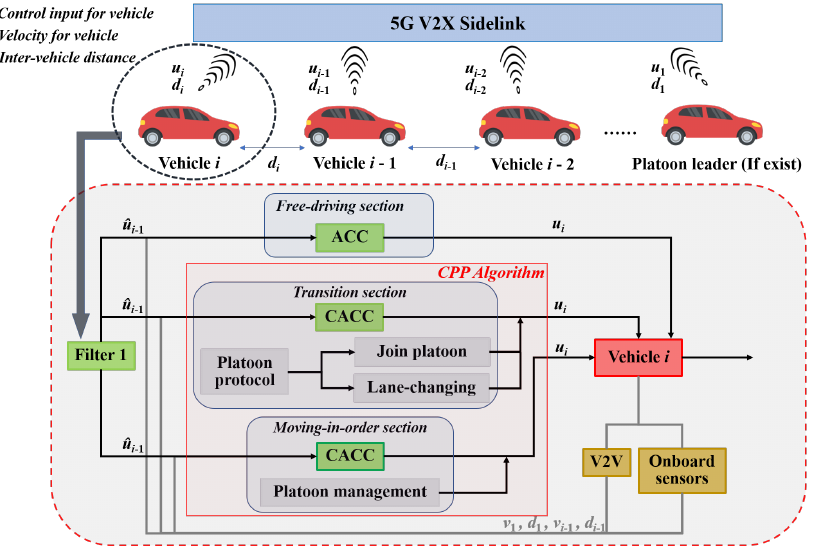
Figure 3. The workflow for the proposed decentralized Coordinated Platooning Planning (CPP) control. The vehicles maintain a safe inter-vehicle distance (safe